Question: Give a one-sentence summary of this figure.
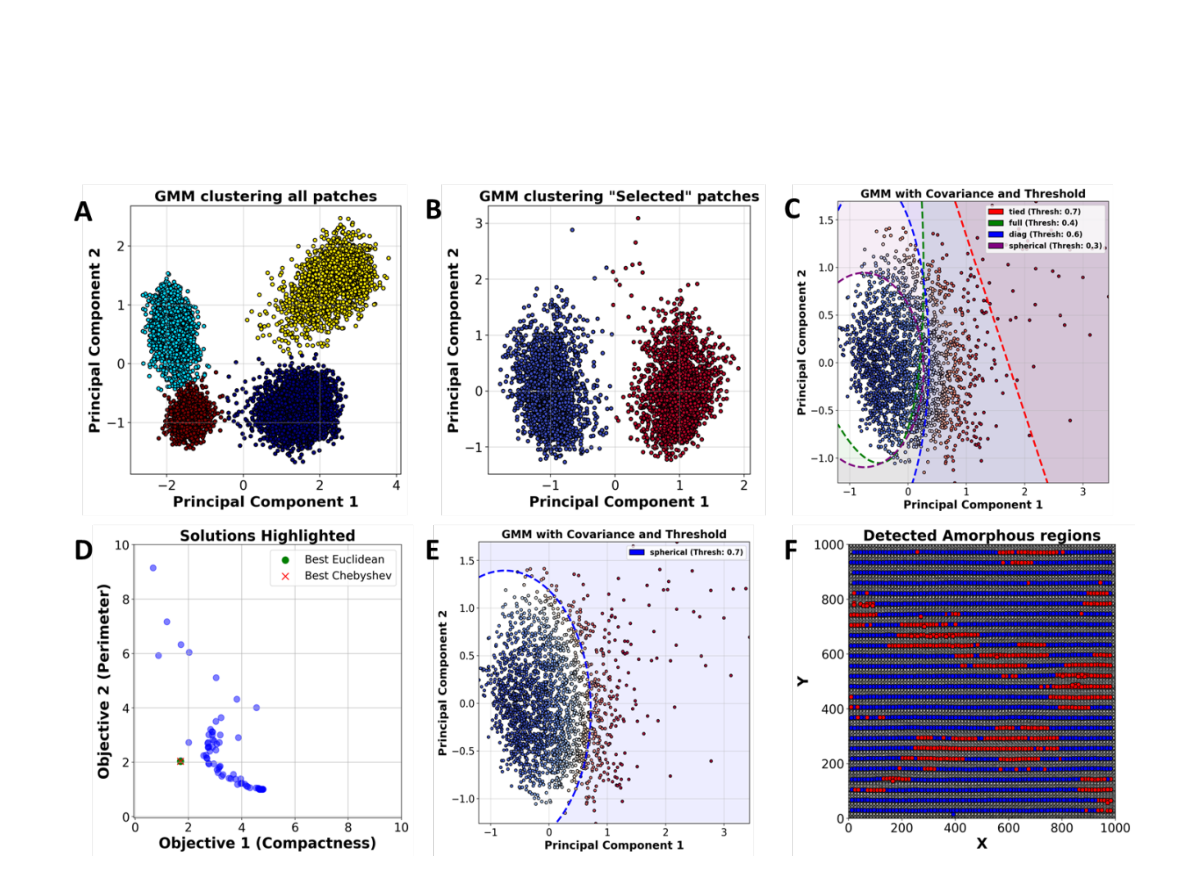
Answer: A) GMM clusters based on all the patches, providing 4 clusters with respect to 4 types  of strong atoms in the YBCO structure. B) GMM clusters based on the patches centered on Ba  atoms, presenting two types of Ba in the YBCO structure, C) GMM clusters based on only one  type of Ba atoms, introducing some variety, which it can be differentiated by different values of  threshold and covariance type in GMM clustering, D) Pareto Frontier solutions with respect to  reward possession), E) Optimal threshold and covariance type achieved by MOBO for GMM  clustering, and F) Uncovered amorphous areas in the substrate.